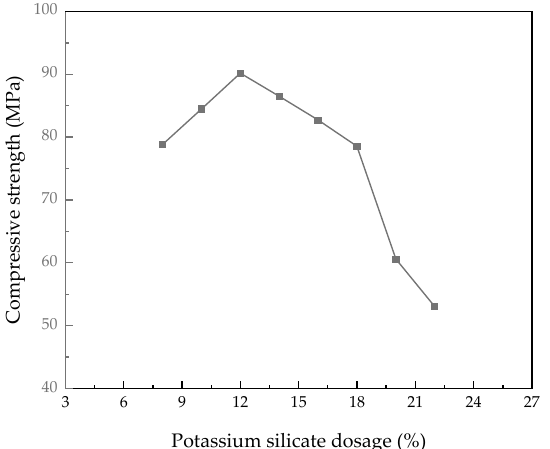
Figure 8. The compressive strength of alkali-activated BFS with different potassium silicate.